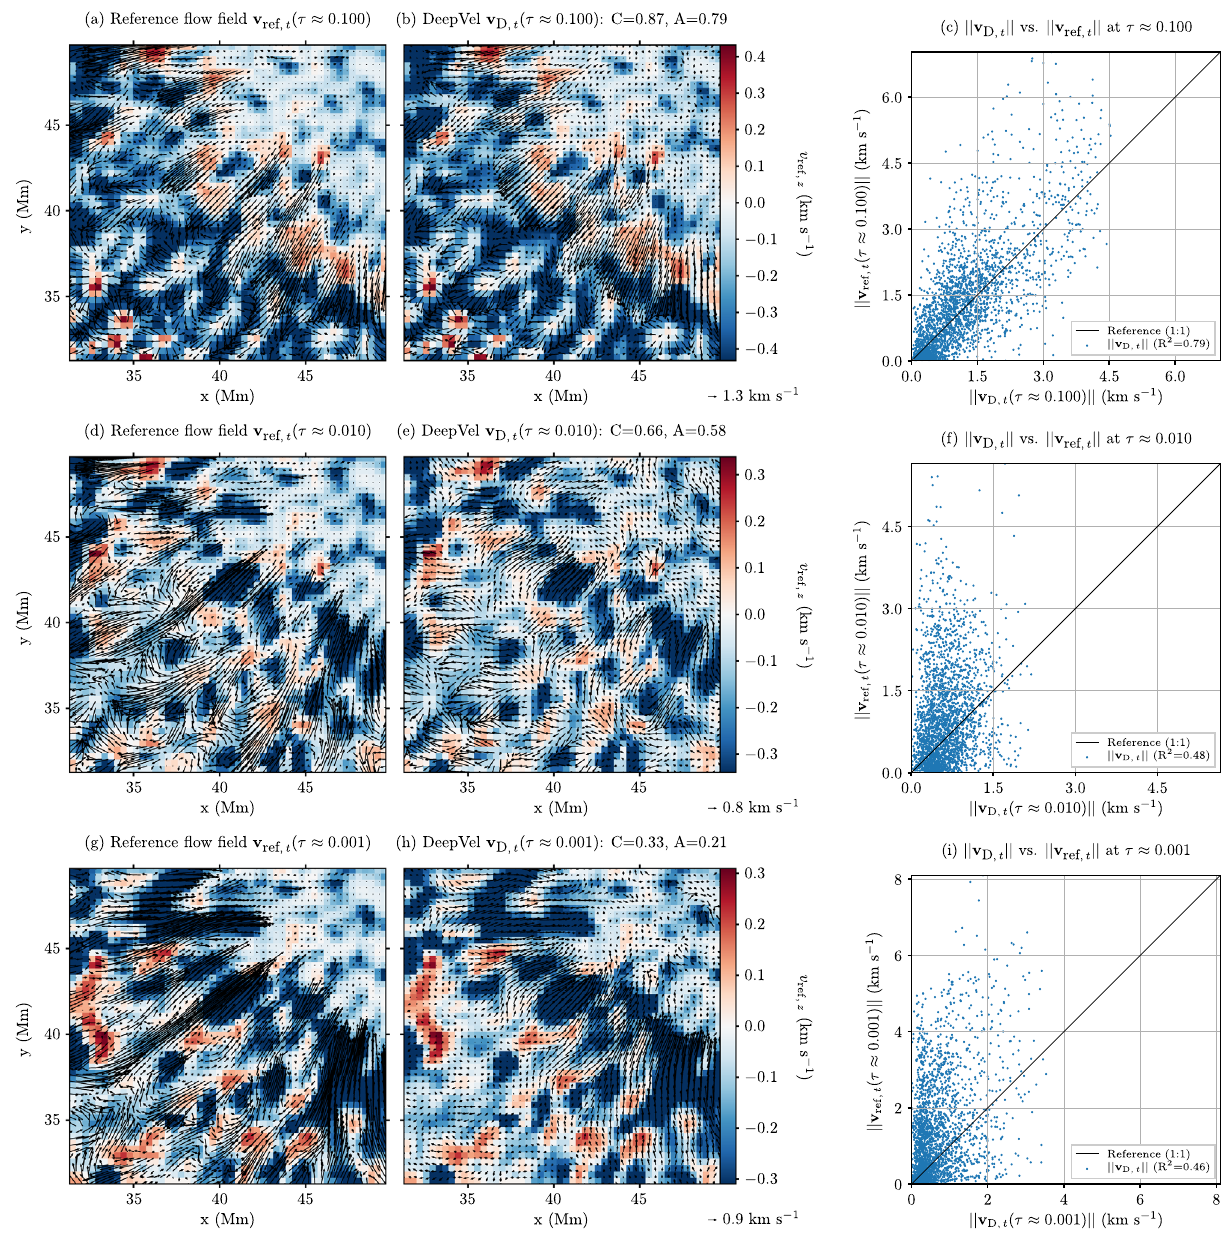
Fig. 5. Above the surface velocity inversions, MURaM-ARs dataset. (Left column) Patches of 50 by 50 pixels 2 extracted from the 30-min-averaged transverse velocity fi elds v D , t ( s , t i ) inferred by DeepVel at optical depths (top) s (cid:2) 0.1, (middle) s (cid:2) 0.01 and (bottom) s (cid:2) 0.001. The time-averaged vertical velocity v s (cid:2) {0.1, 0.01, 0.001}, t i ) computed by the MURaM-ARs simulation and resampled to the ref, z ( SDO/HMI resolution is displayed as colored background. (Right column) Scatterplots comparing amplitudes || v D , t || to || v ref, t ||. The black line represents the expected solution (i.e., a coef fi cient of determination R 2 =